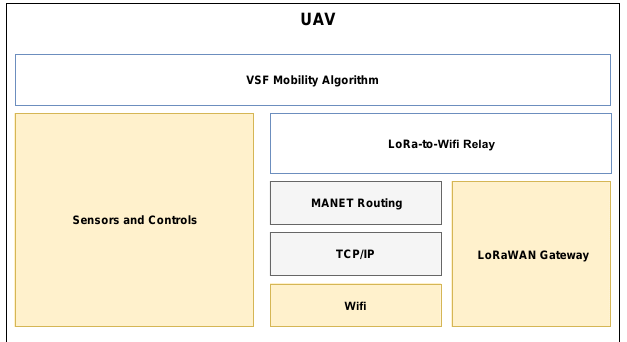
Figure 3. System Stack of